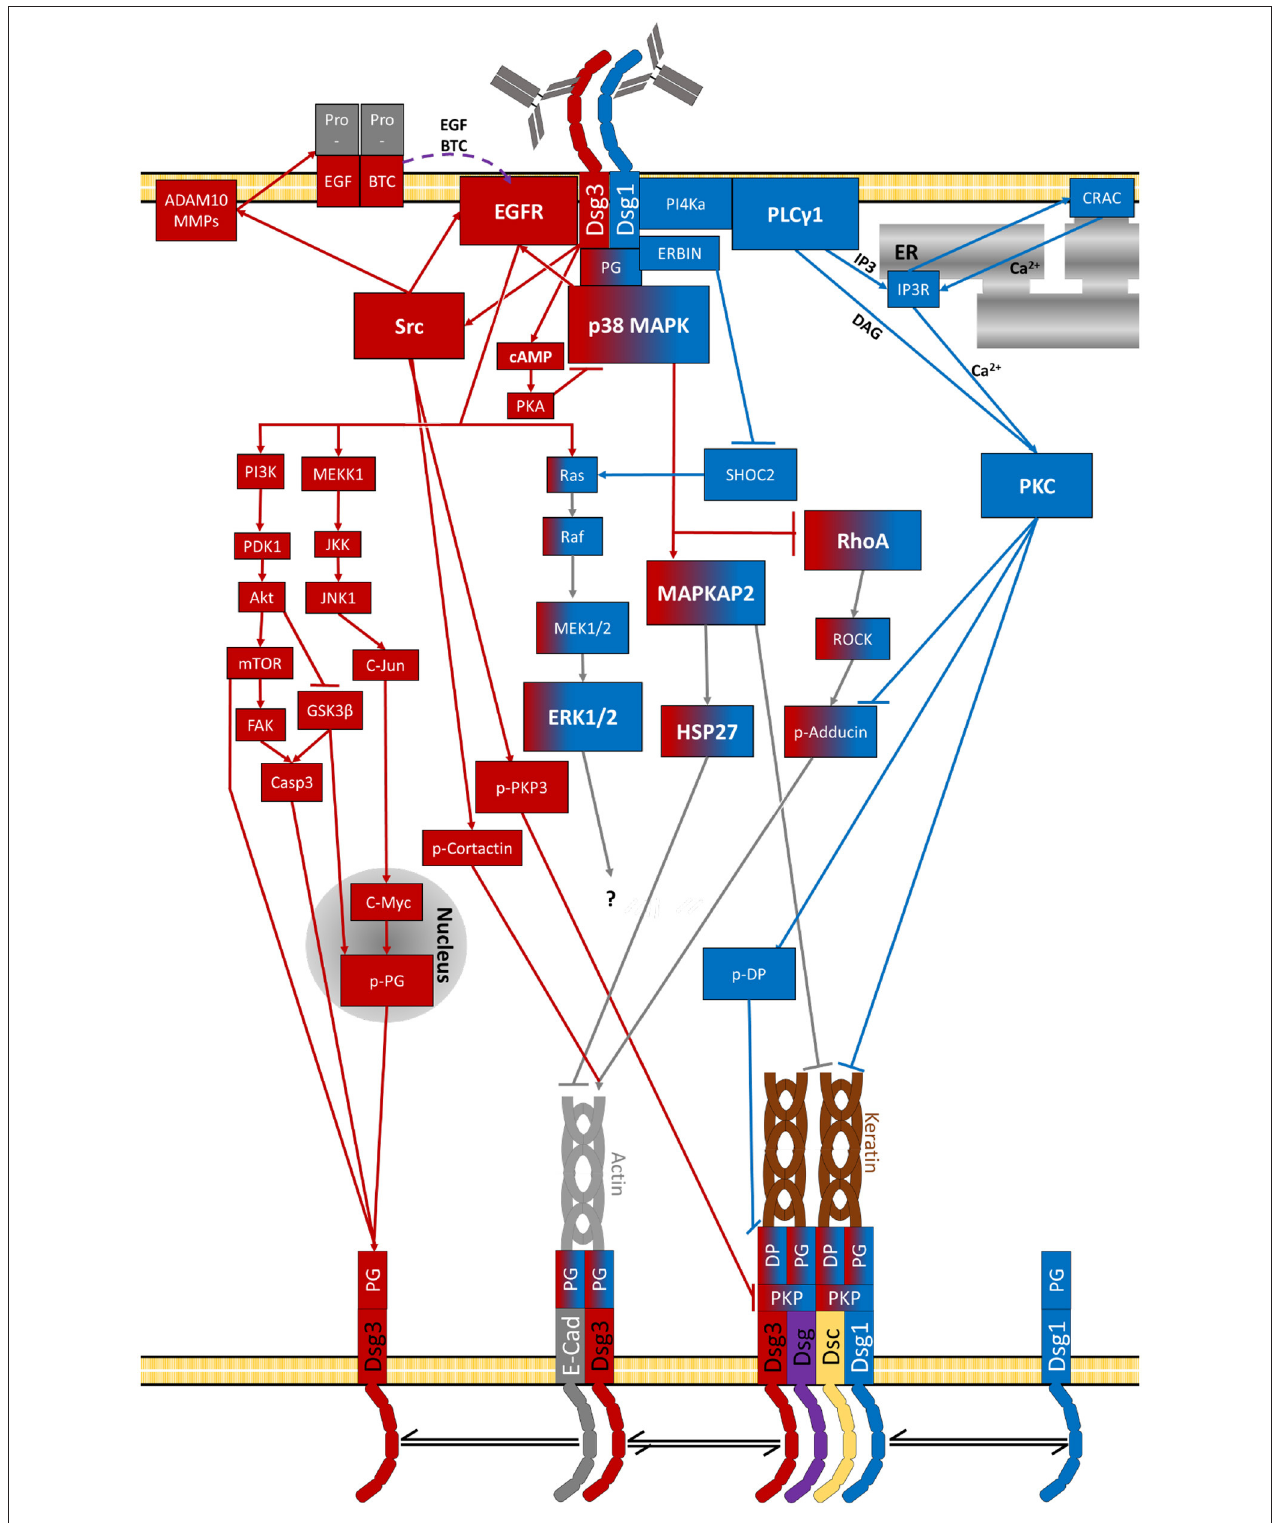
FIGURE 5 | Signalling pathways activated by pemphigus-IgG (purple lines indicate diffusion of extracellular second messengers). The specific target of Erk1/2-Elk1 is not known.